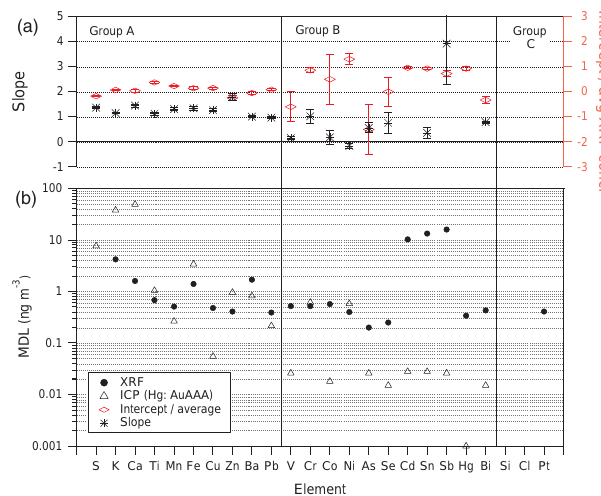
Figure 3. (a) Slopes and intercept ratios (intercepts divided by the average concentrations measured with XRF) with standard devia- tions for all elements measured with the Xact. (b) Minimum detec- tion limits (MDL), interference free for the Xact 625 (XRF) and for the ICP analyses. Hg was analysed with AuAAA